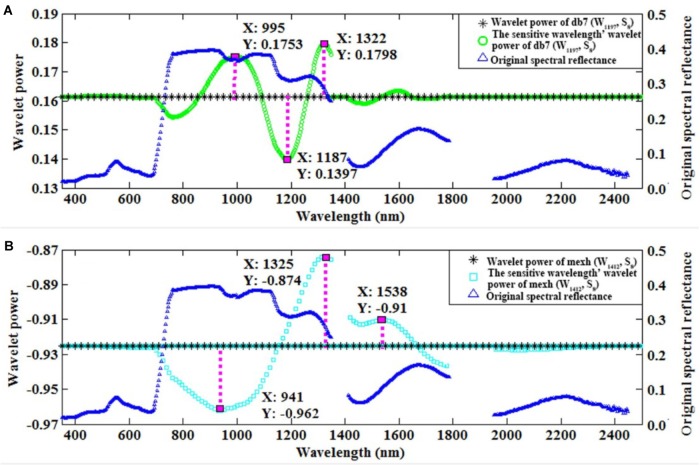
The original spectral reflectance, wavelet power, and sensitive wavelength’ wavelet power of db7 (W1197, S8) (A) and mexh (W1412, S8) (B).